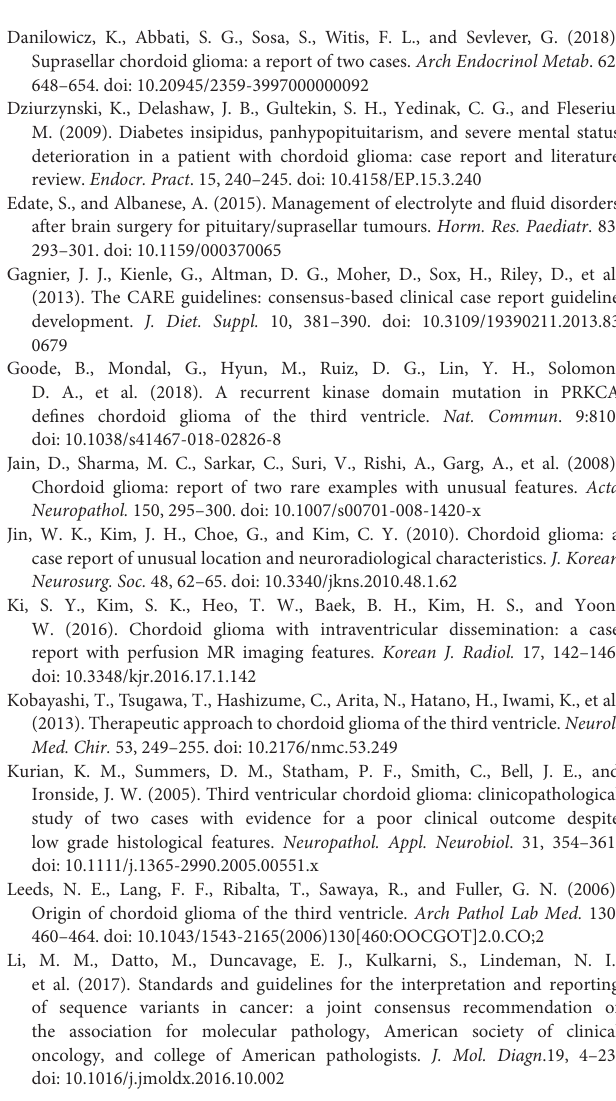
Supplementary Table 1 | Laboratory test results at baseline, and post-operative 30 and 50 days. Supplementary Table 2 | Reported cases of collision of chordoid glioma. Supplementary Table 3 | Endocrine dysfunction